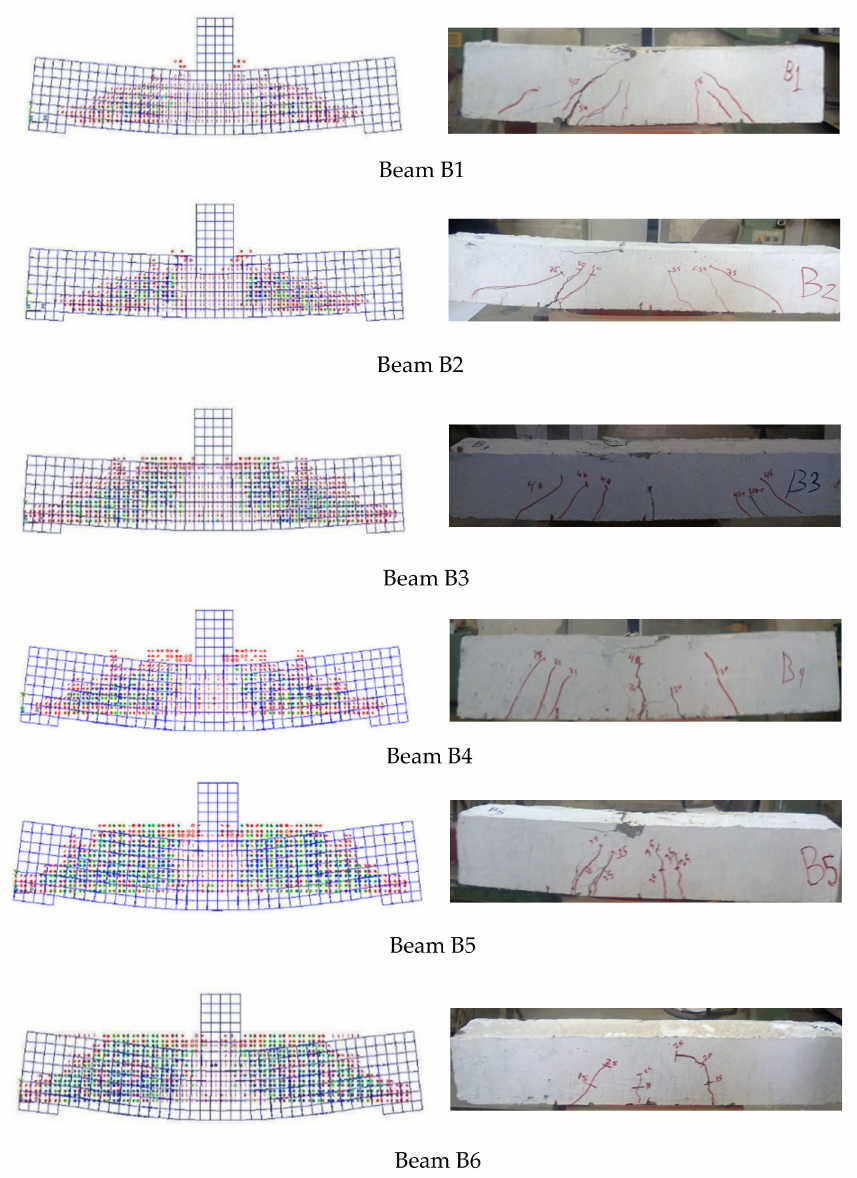
Figure 15. Comparisons of the numerical simulation results with the experimental ones in terms of the cracking patterns and failure modes